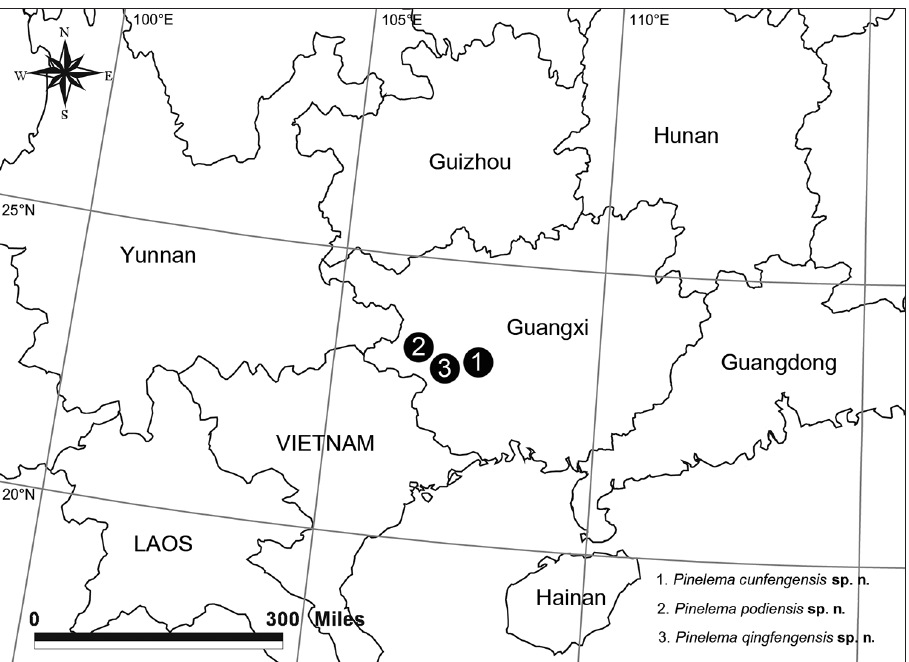
Figure 13. Type localities of three new Pinelema species from caves in Guangxi,